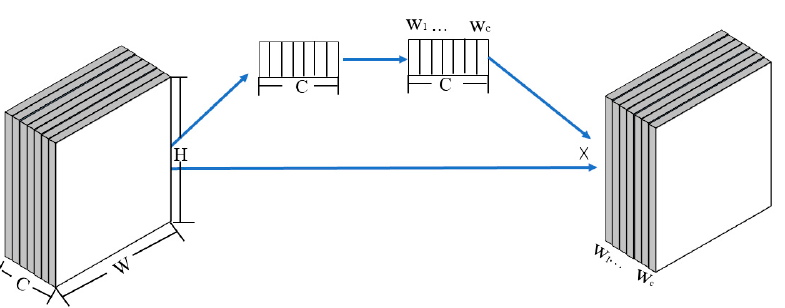
Figure 3. Detailed network structure of the squeeze-and-excitation (SE) module, wherein C is the channel of the feature map, W and H are width and height of the feature maps, and W 1 , . . . W c is the weight of each channel of the feature map.